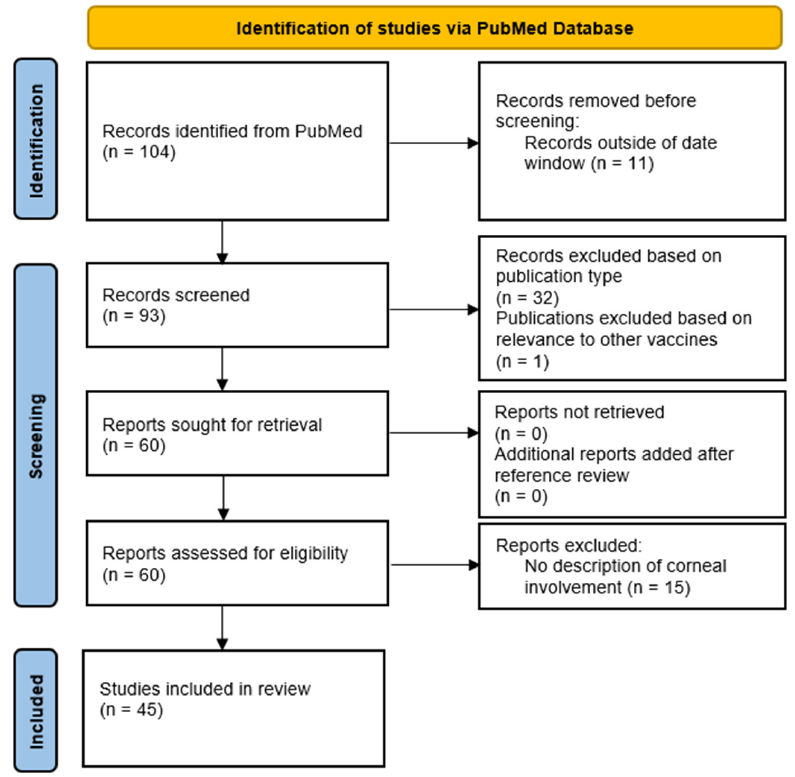
Figure 1. PRISMA flow diagram for this systematic review of the literature.